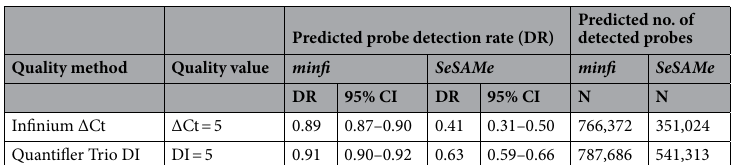
Predicted probe detection rate (DR)